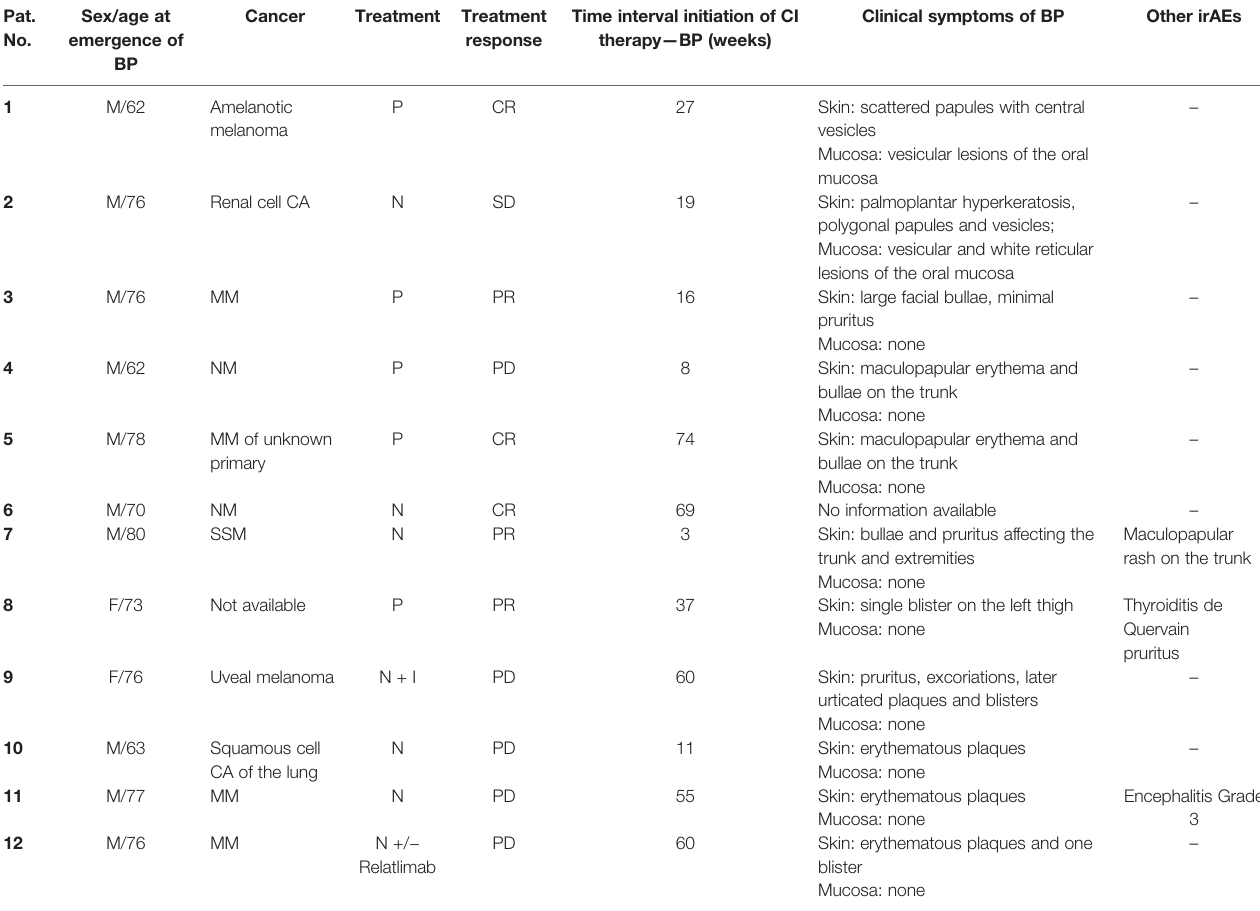
TABLE 1 | Clinical features of patients diagnosed with bullous pemphigoid (BP) under CI therapy. Pat. No.